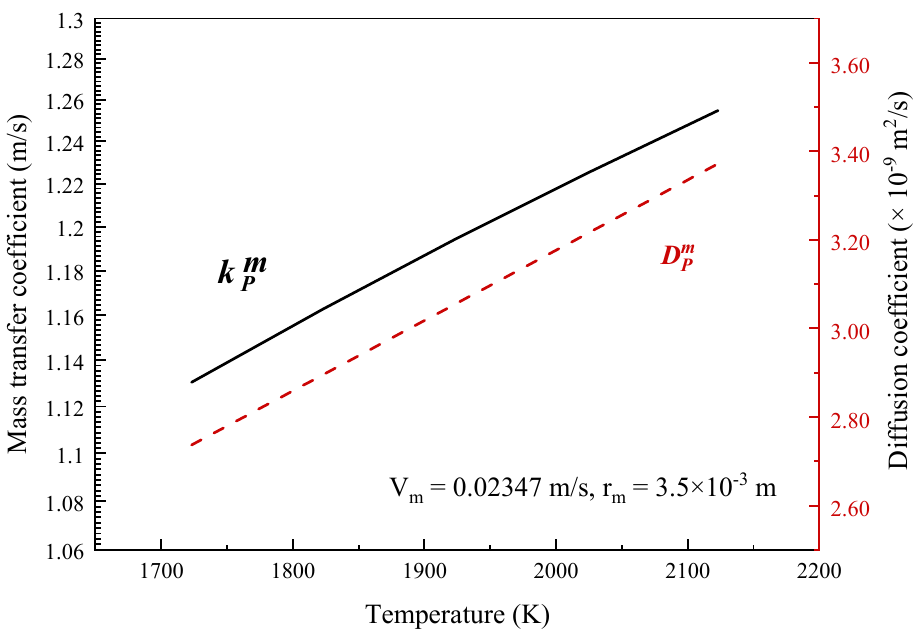
Figure 2. Effects of temperature on the diffusion coefficient and mass transfer coefficient of phosphorus in the boundary layer.